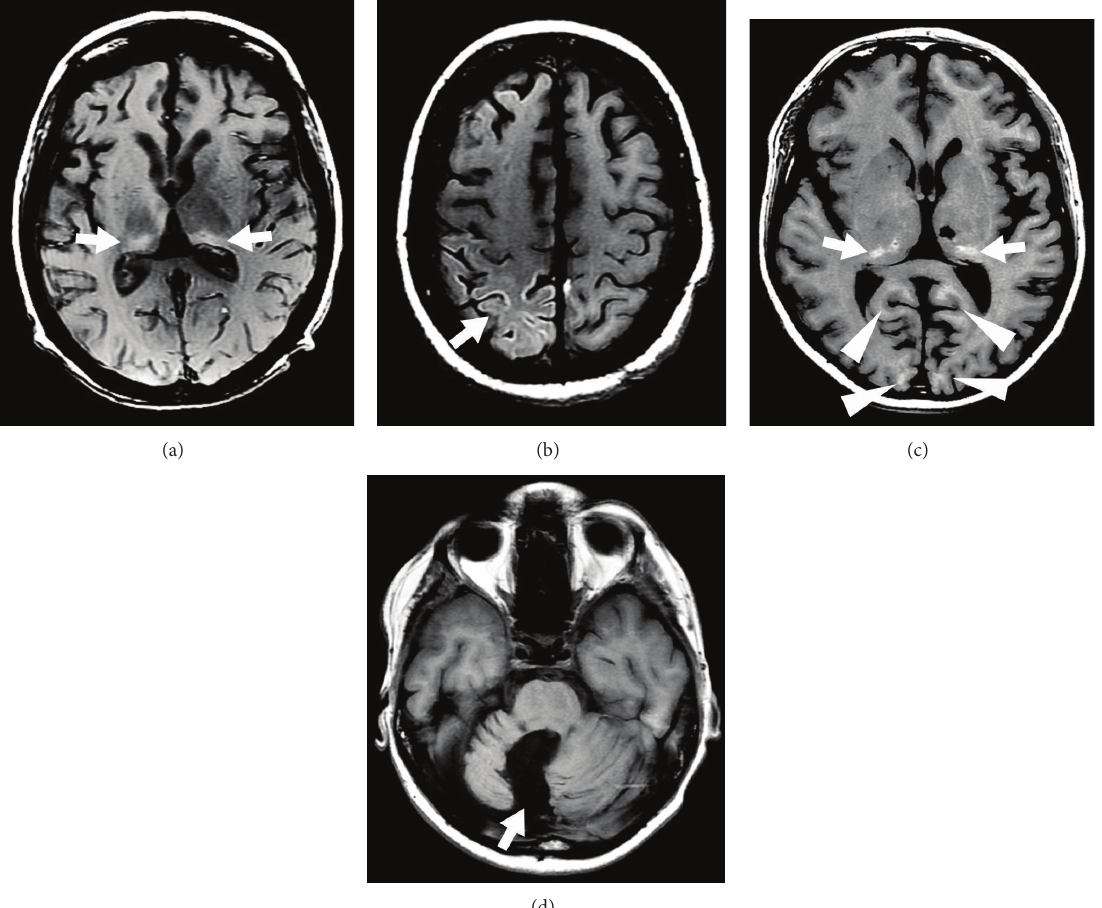
Figure 24: T1-weighted MRI of patient 1 (a and b) after generalized status epilepticus and patient 2 (c and d) with a history of cerebellar astrocytoma treated by surgical resection and large field radiation therapy including the occipital lobes and both thalami showing laminar necrosis of both thalami (a and c, arrows) associated with laminar necrosis in the right-sided parietal cortex (b, arrows) and in the bilateral occipital cortex (c, arrowheads). Panel (d) shows the cerebellar cavity due to cerebellar astrocytoma